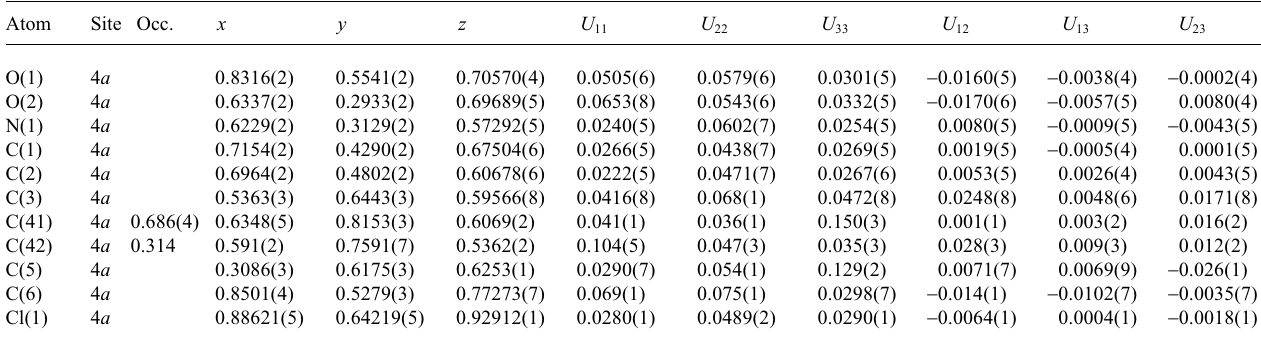
Table 3. Atomic coordinates and displacement parameters (in Å 2 ).